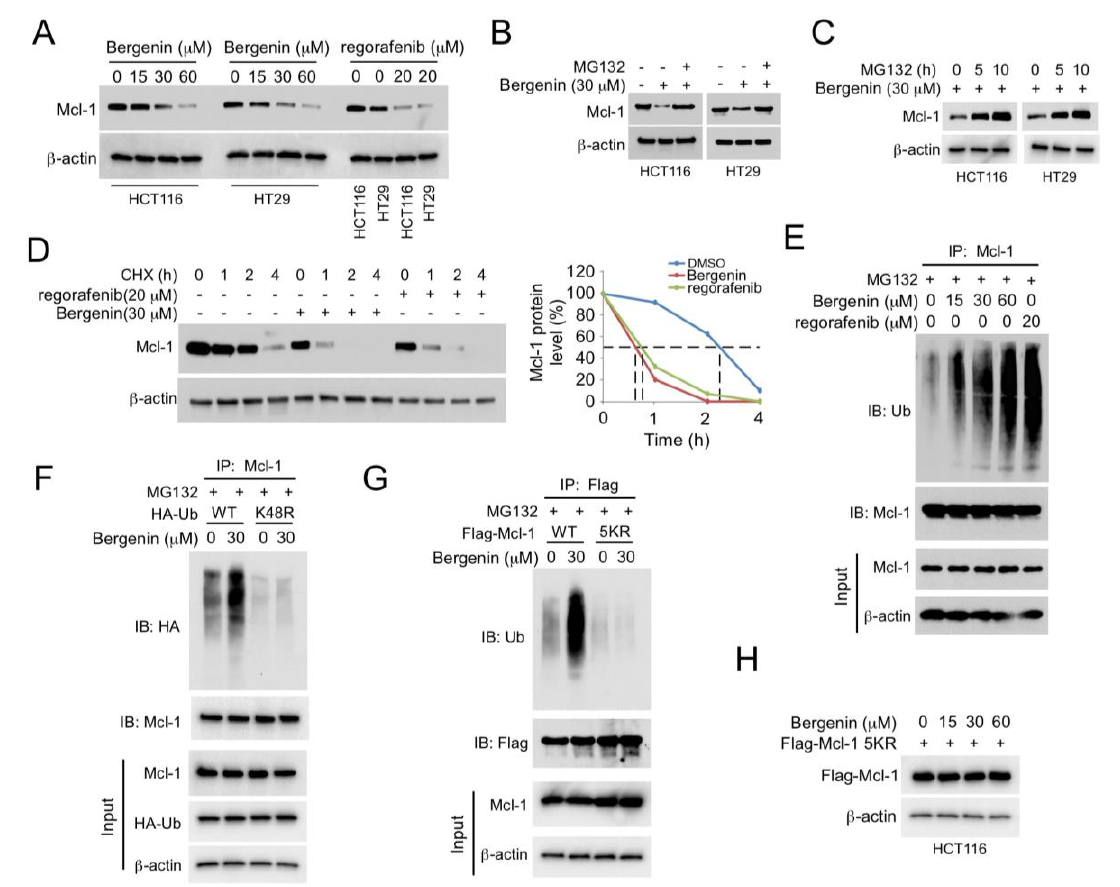
Figure 2. Bergenin induces Mcl-1 degradation. ( A ) Bergenin − treated or regorafenib − treated HCT116 and HT29 were cultured for 48 h. WCE were collected for IB analysis. Regorafenib was used as positive control. ( B ) Bergenin − treated HCT116 and HT29 were cultured for 48 h, followed by culture with 20 µM MG132 for an additional 10 h. WCE were collected for IB analysis. ( C ) Bergenin − treated HCT116 and HT29 cells were cultured for 48 h, followed by culture with 20 µM MG132 for different time points. WCE were collected for IB analysis. ( D ) Bergenin − treated or regorafenib − treated HCT116 and HT29 cells were cultured for 48 h, followed by culture with CHX for different time points. The WCE were collected for IB analysis. Regorafenib was used as positive control. ( E ) Bergenin − treated or regorafenib − treated HCT116 and HT29 cells were cultured for 48 h, followed by culture with 20 µM MG132 for 10 h. WCE were collected, immunoprecipitated with Mcl − 1 antibody, and analyzed for Mcl − 1 ubiquitination. Regorafenib was used as positive control. ( F ) HCT116 cells were transfected with the HA − Ub wild type or the K48R mutant sequences for 24 h, incubated with bergenin for 48 h, followed by culture with 20 µM MG132 for 10 h. WCE analysis was performed according to the Mcl − 1 ubiquitination analysis. ( G ) HCT116 cells were transfected with Flag − Mcl − 1 WT or the 5KR mutant sequence for 24 h, incubated with bergenin for 48 h, followed by incubation with 20 µM MG132 for 10 h. Mcl − 1 ubiquitination analysis for WCE. ( H ) HCT116 cells were transfected with Flag − Mcl − 1 WT or the 5KR mutant for 24 h and incubated with bergenin for 48 h. WCE were collected for IB analysis. WCE, whole cell extracts; IB, immunoblotting; CHX, cycloheximide; Mcl − 1, myeloid leukemia 1; WT, wild − type.